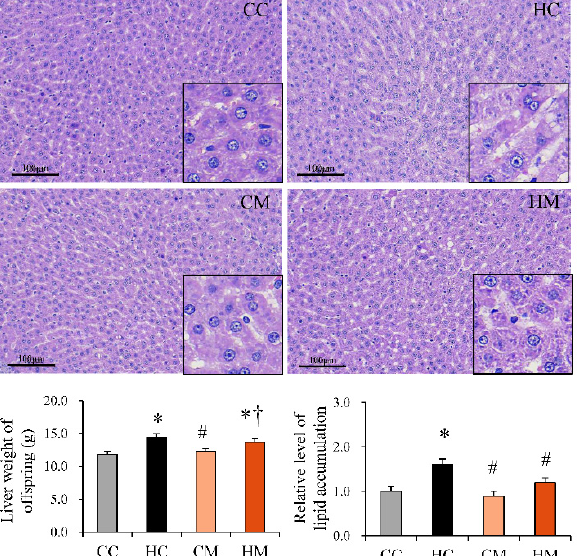
Figure 8. Liver weight and histological manifestations of 120-day-old offspring fed a maternal control diet (CC), maternal high-fat diet (HC), maternal control diet with maternal metformin treatment after mating (CM), or maternal high-fat diet with maternal metformin treatment after mating (HM). All the offspring received a control diet after weaning. The degree of hepatic steatosis is presented as a vacuolation increase via hematoxylin and eosin (H&E) stain. Magnification of boxed area detailing the hepatocytes. * Compared to the CC group, p < 0.05; # compared to the HC group, p < 0.05; † compared to the CM group, p < 0.05.